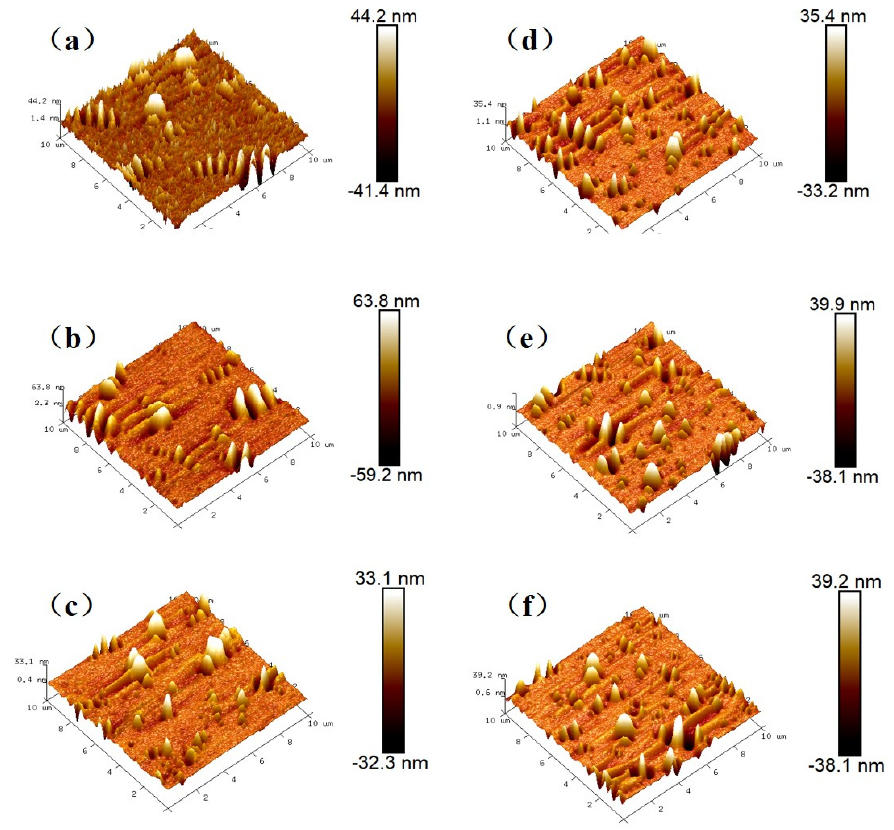
Figure 4. ( a ) 3D AFM images of base asphalt; ( b ) base asphalt after RTFOT aging; ( c ) base asphalt after PAV aging; ( d ) graphene-modified asphalt; ( e ) graphene-modified asphalt after RTFOT aging; ( f ) graphene-modified asphalt after PAV aging.